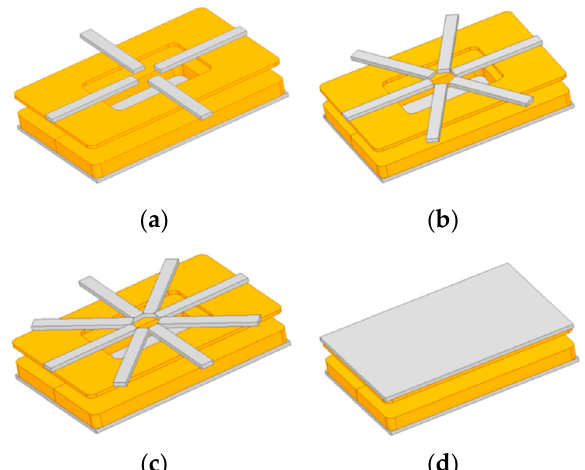
Figure 6. Comparison of optimization of rectangle coil core structure: ( a ) 4 magnetic cores, ( b ) 6 magnetic cores, ( c ) 8 magnetic cores, ( d ) fully covered cores.